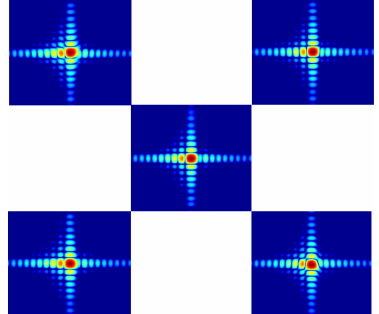
Figure 16. Imaging results of Case 2 without the BTD error compensation.